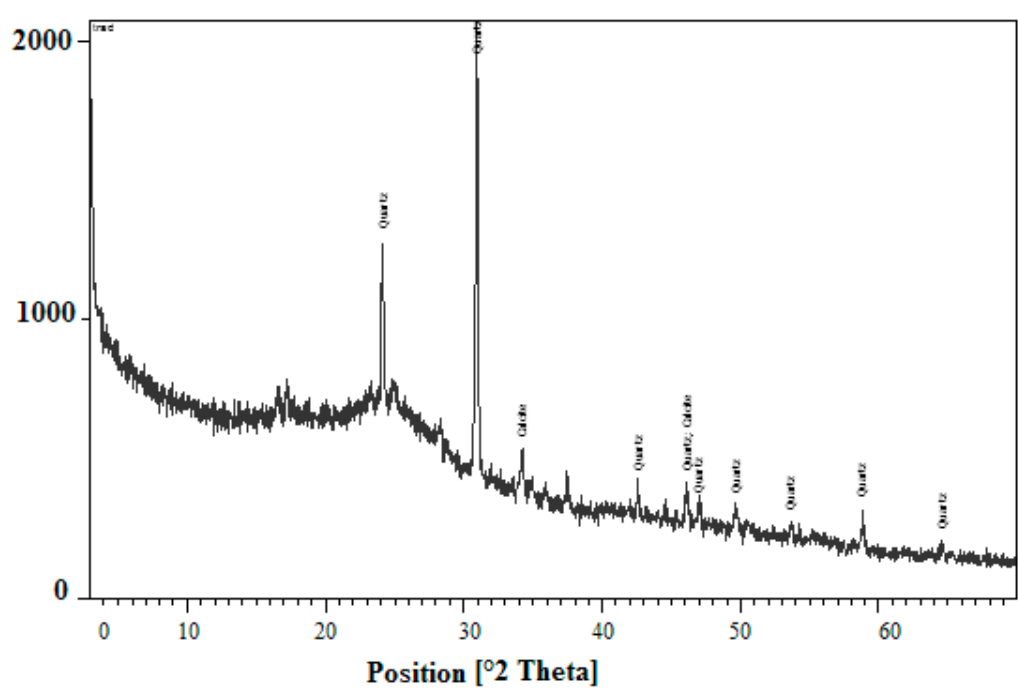
Figure 1. X-ray diffractogram of olive mill solid waste.